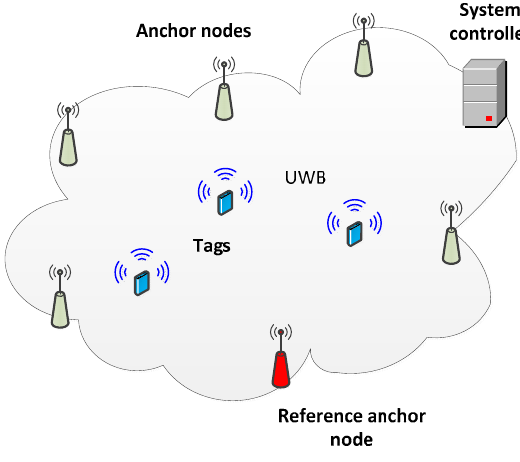
Figure 2. Monitoring system architecture.